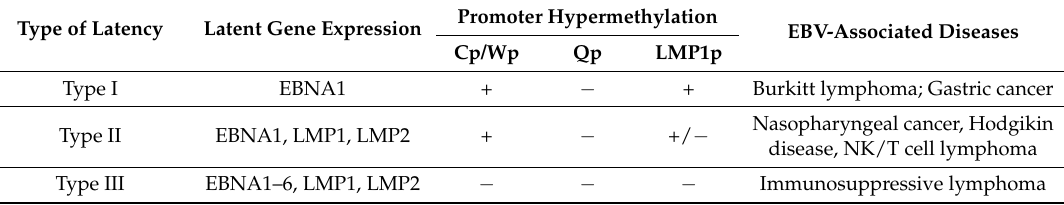
Table 1. The pattern of Epstein Barr virus (EBV) latent gene expression and promoter